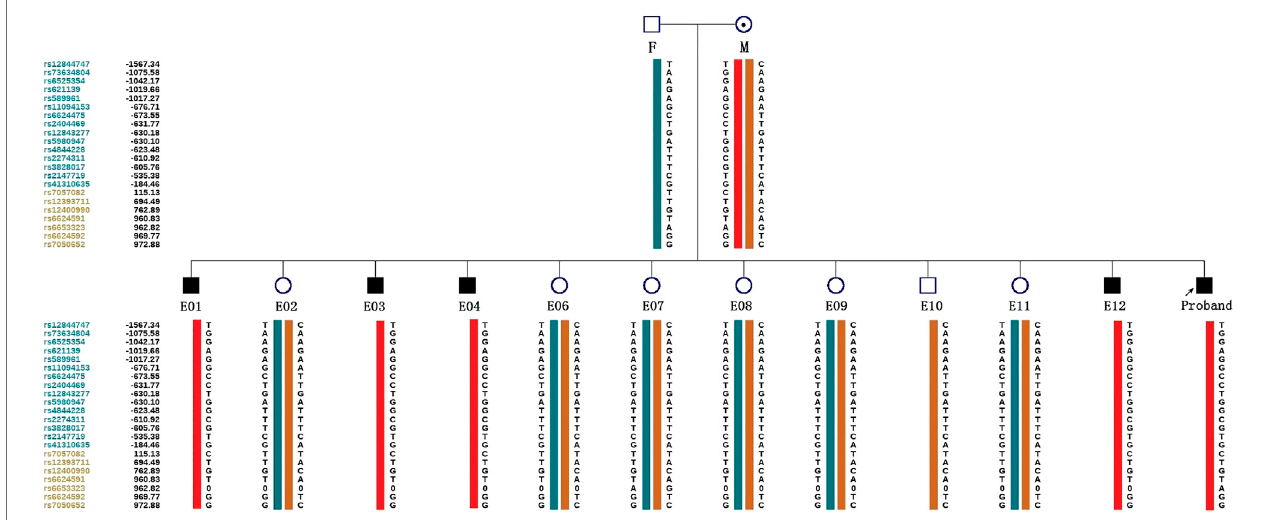
FIGURE 3 | Schematic diagram representing the SNP-based haplotype of this family members and embryos. F, M, and P represent the father, mother, and proband, respectively. The reference SNP cluster ID numbers were listed on the left side. The ID numbers highlighted in dark blue and orange refer to the upstream and downstream informative SNPs, respectively. Thered bar refer tothe high-risk haplotypes, the dark blue bar representthe normal or low-risk haplotype ofthe father,and the dark orange bar represent the normal or low-risk haplotype of the mother. Results show that the E01, E03, E04, and E12 are male patient embryos; the E02, E06, E07, E08, E09, and E11 are normal female embryos; and the E10 is a normal male embryo. E05 was not included because of anomalies found in the linkage